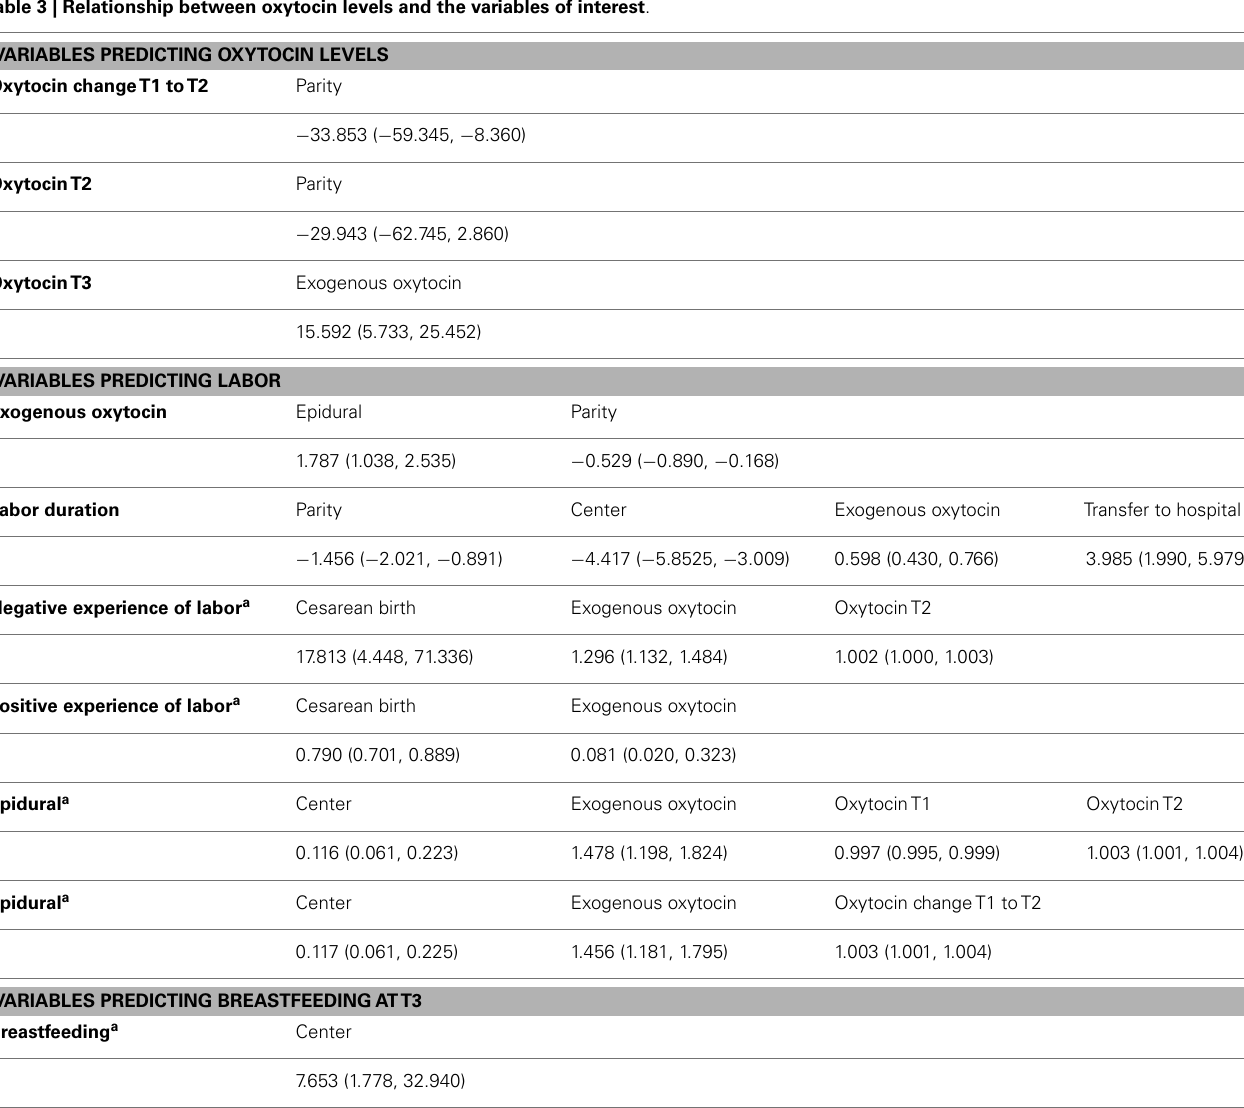
Table 3 | Relationship between oxytocin levels and the variables of interest